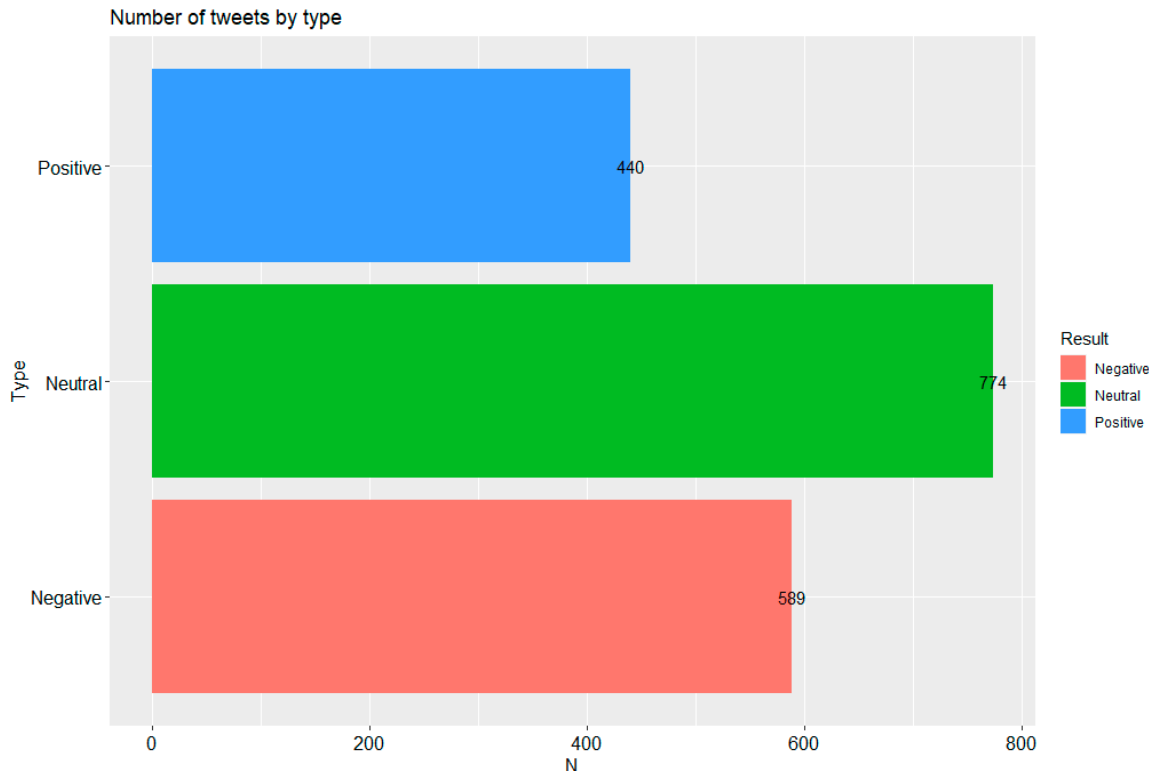
Figure 3. Number of tweets according to type. Made using the ggplot2 library in R. The green bar shows the number of tweets that do not contain charged tweets or the number of tweets for which the number of negative words used in the sentence equals the number of positive words. The blue bar shows the number of tweets in which the positive words used constitute the majority in the tweet, while the red bar is the opposite (the bar shows the number of tweets in a sentence in which the negative words used constitute the majority in that tweet).